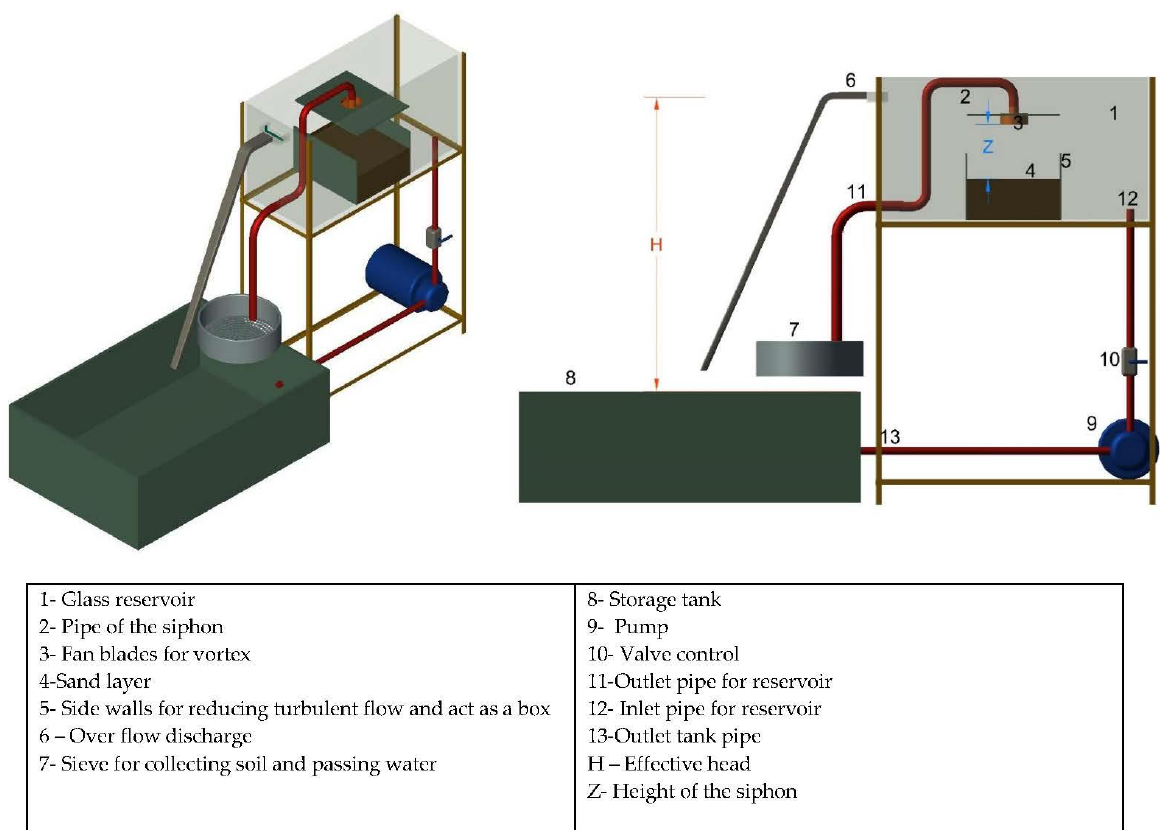
Figure 1. The laboratory tank model and description of parts.